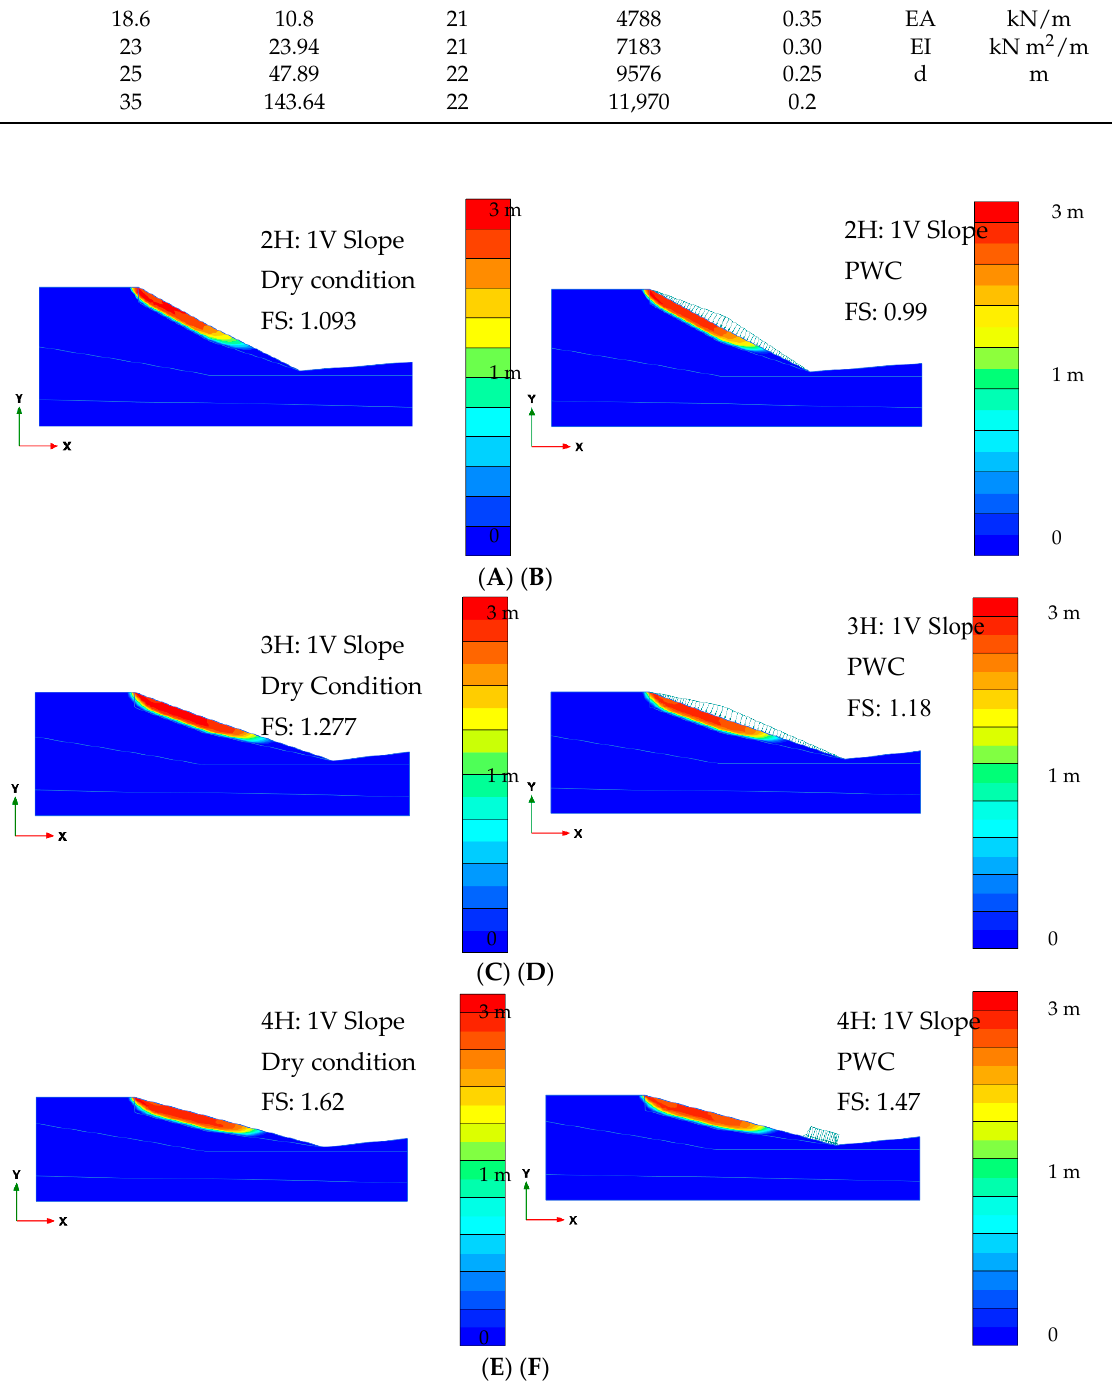
Figure 3. Stability analysis of the unreinforced slope: ( A ) 2H:1V slope (dry condition), ( B ) 2H:1V slope (PWC), ( C ) 3H:1V slope (dry condition), ( D ) 3H:1V slope (PWC), ( E ) 4H:1V slope (dry condition), and ( F ) 4H:1V slope (PWC).